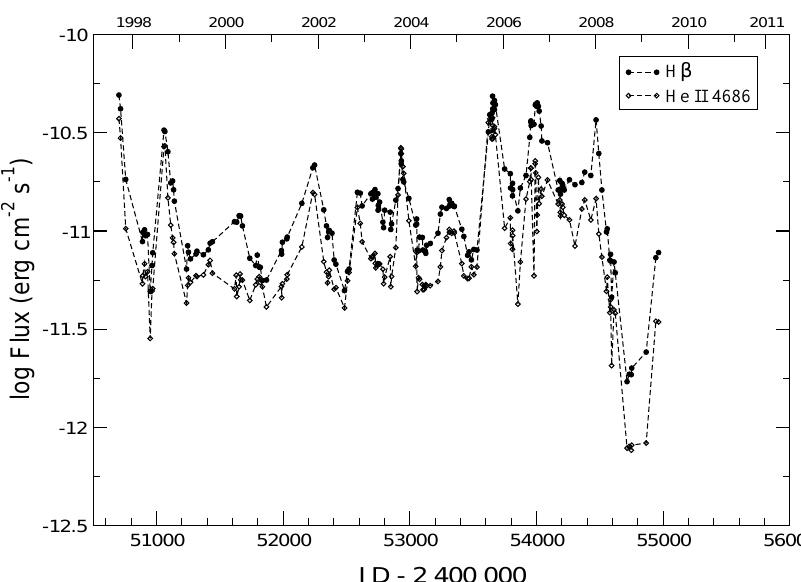
Fig. 7. Absolute (cid:13)uxes emitted in the H (cid:12) and the He II (cid:21) 4686 lines in 1997{2009. (cid:21) 1032 (and (cid:21) 1038) undergo Raman scattering on the atoms of neutral hydrogen (Schmid 1989). Weakening and disappearance of these lines could either indicate weakening of the O VI resonance lines (due to decreasing temperature) or a